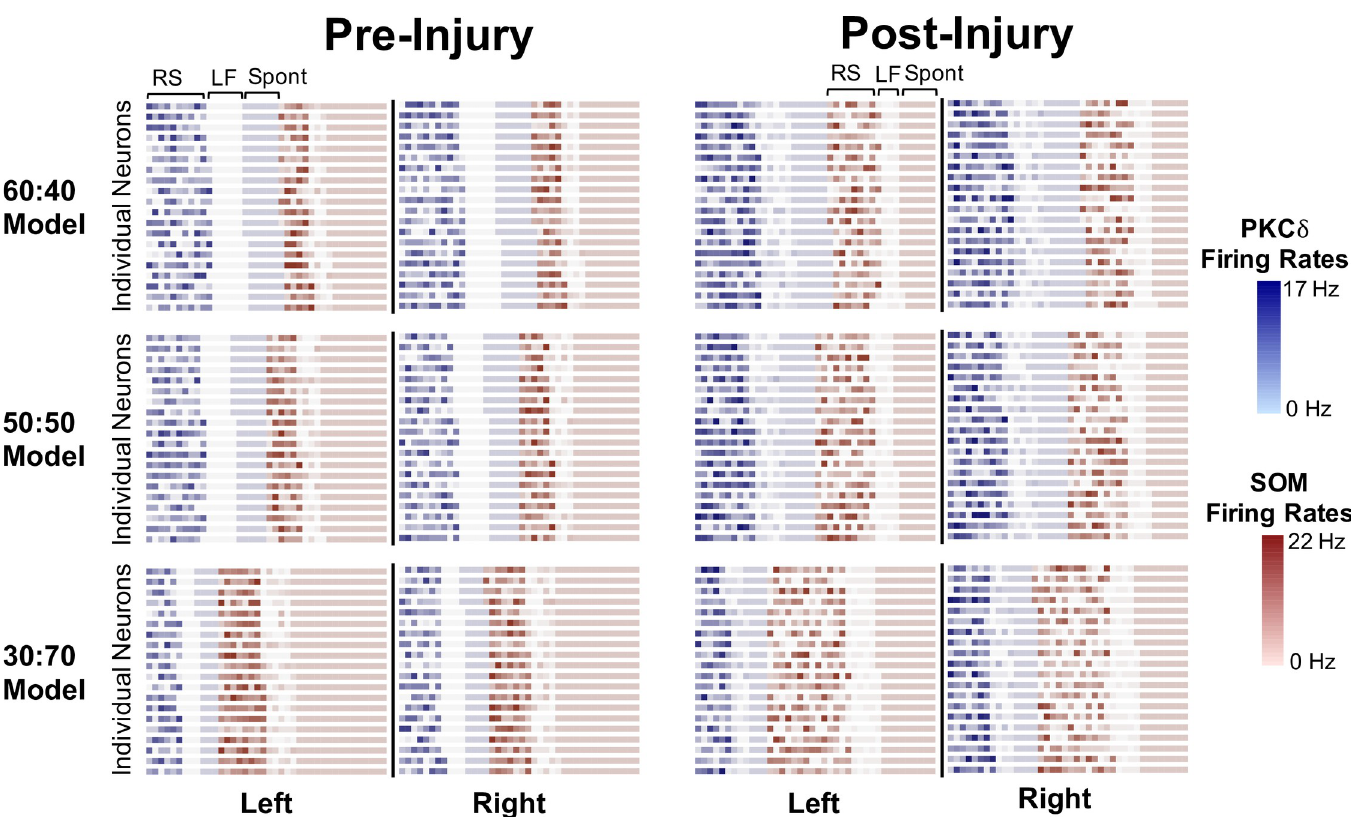
Fig 7. Individual neuron firing rates before and after injury. For each of our three models, the firing rates of all 1600 neurons during a simulation with constant 120 pA were outputted before injury (t = 10) and after injury (t = 240). Darker hues correspond to higher firing rates in PKC δ neurons (blue) and SOM neurons (red). Regular spiking (RS), late firing (LF), and spontaneous (Spont) SOM and PKC δ neurons are grouped together in each plot. Across all three models, the firing rates of PKC δ RS and LF neurons increase with injury and the firing rates of SOM RS and LF neurons decrease with injury (corresponding to lab data in Fig 1 ). However, injury also results in an increase in the quantity of SOM RS neurons and a decrease in the quantity of SOM spontaneous neurons (corresponding to lab data in Fig 2 ). Data on the left and right are the same for the 60:40 and 50:50 models, but distinct for the 30:70 model (corresponding to lab data in Fig 6